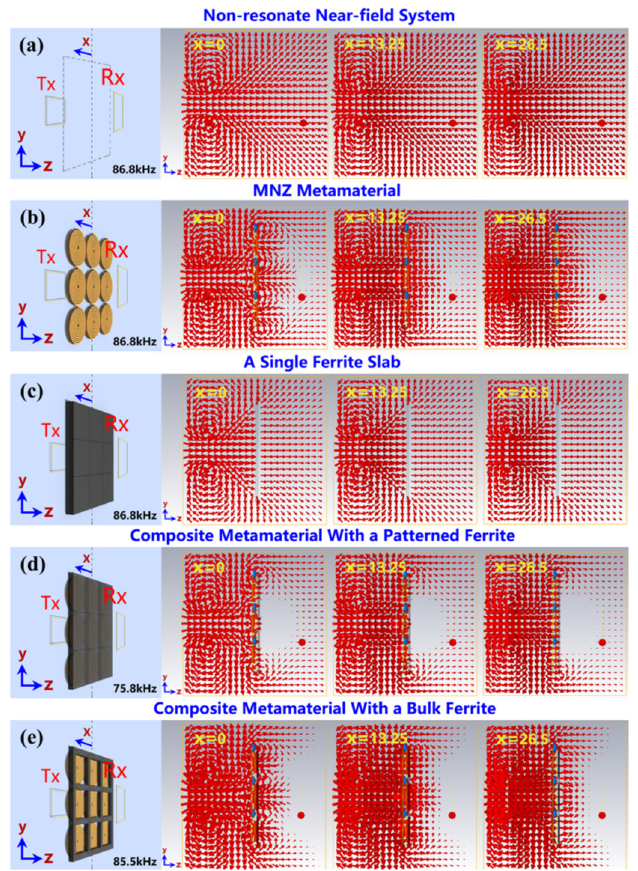
Fig. 3. The scheme of the simulation and the magnetic fi eld results. Since (a) and (c) are non-resonant, the same frequency as (b) was chosen to observe the magnetic fi eld. For other samples, the magnetic fi eld at the frequency of maximum SE is shown. The left side is a scheme of each comparison. Starting from the gray dotted line ( x = 0), three yoz slices are selected along the x direction. The slices represent the three positions of the most central unit (center position of the unit: x =0 mm, 1/4 position of the unit: x = 13.25mm, boundary position of the unit: x =26.5 mm).